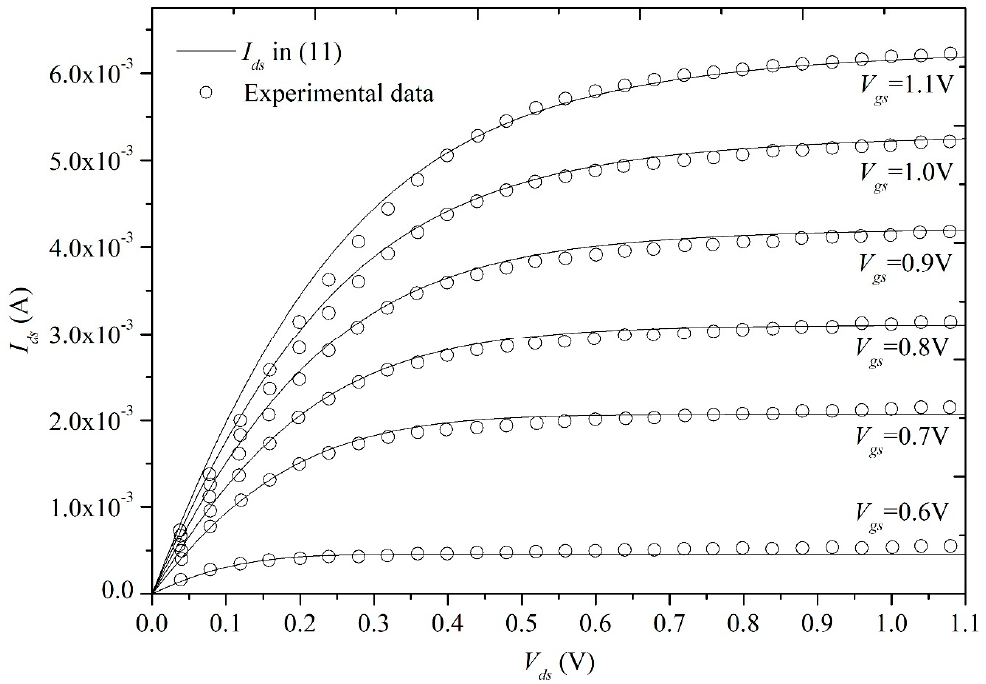
Figure 6. Comparisons of transfer characteristics between our drain current model results and short-channel experimental data [22] from Khandelwal et al.